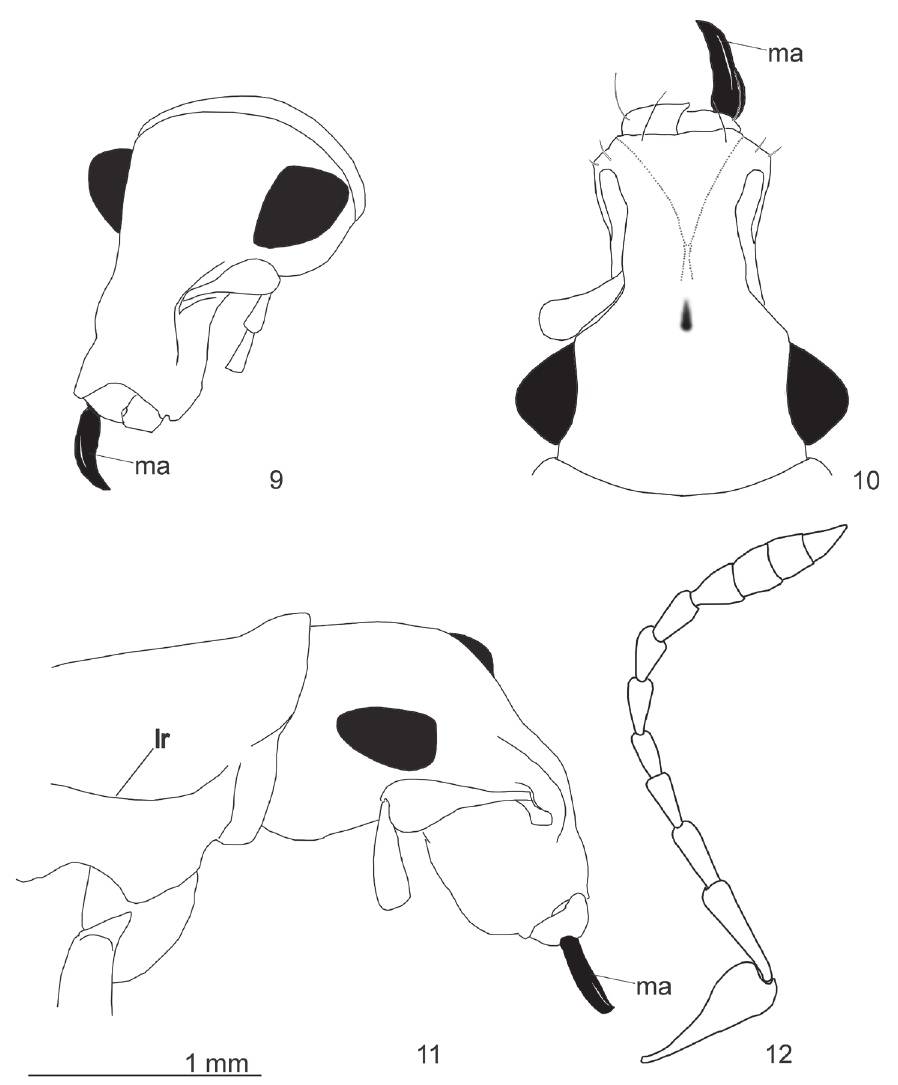
Figures 9–12. Arostropsis groehni gen. et sp.n. 9 head, antero-lateral view 10 idem, antero-dorsal view 11 head and prothorax, lateral view 12 antenna, lateral view. Abbreviations: lr lateral ridge, ma mandibular process. Scale bar: 1